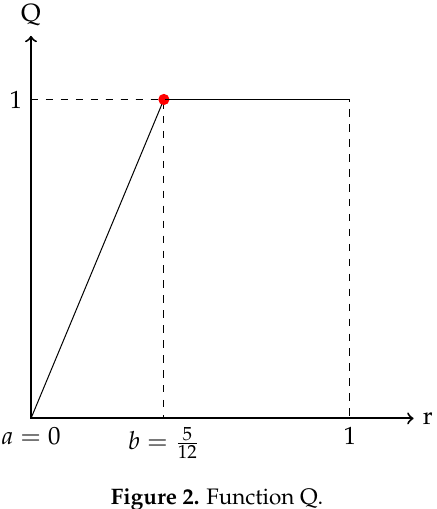
Figure 2. Function